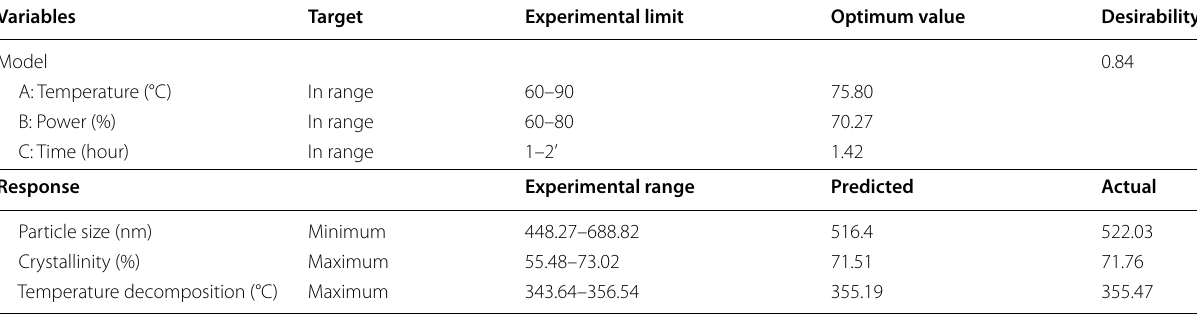
Table 3 Optimization parameter limit (actual and optimized) values and desirability toward responses (particle size, crystallinity,